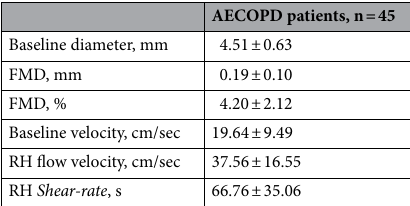
Table 2. Endothelial function parameters by brachial artery measurement.